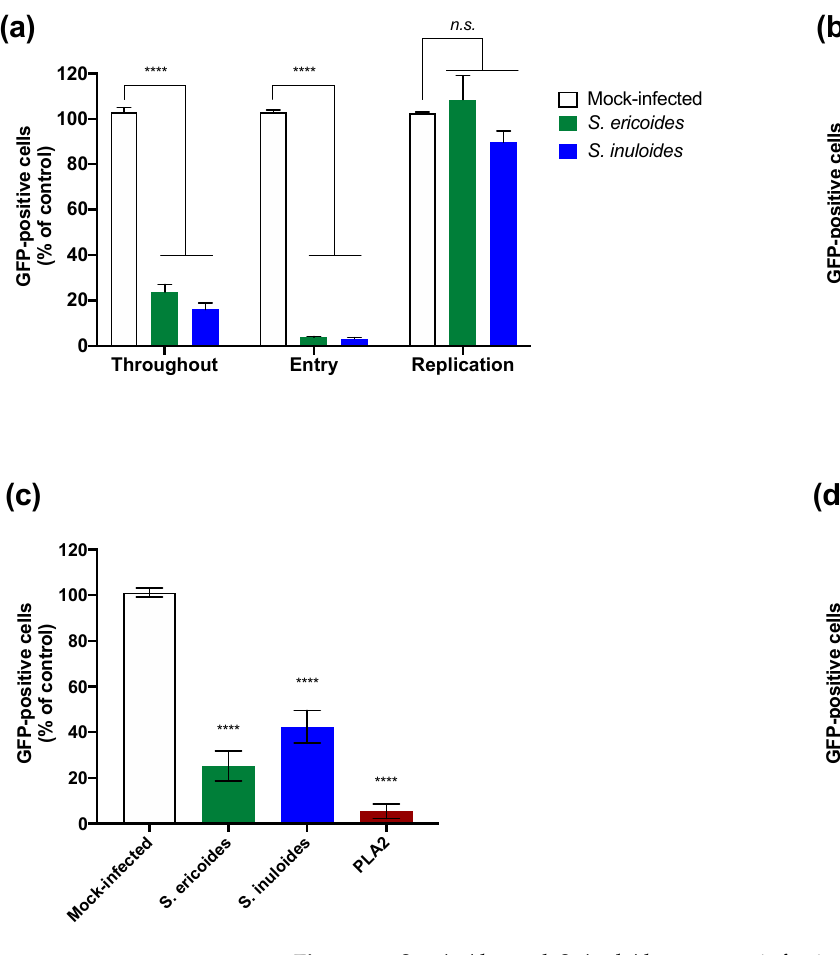
Figure 3. S. ericoides and S. inuloides prevent infection of A549 cells by acting differently on the early stages of ZIKV infectious cycle. ( a ) Flow cytometric analysis of GFP expression in ZIKV GFP - A549 infected cells during 24 h at different times of addition of Stenocline extracts (100 µ g.mL − 1 ). ( b ) A549 cells were infected with ZIKV GFP pre-incubated during 1 h at 37 ◦ C with 100 µ g.mL − 1 of Stenocline extracts. Phospholipase A2, PLA2 (10 µ M) was used as a positive control. Flow cytometric analysis of GFP fluorescence was performed 24 hpi. ( c ) A549 cells were infected with ZIKV GFP at an MOI of 1 for 1 h at 4 ◦ C in the presence of Stenocline extracts (100 µ g.mL − 1 ), and then the temperature was shifted to 37 ◦ C in absence of plant extracts. Phospholipase A2, PLA2 (10 µ M) was used as a positive control. Flow cytometric analysis of GFP fluorescence was performed at 24 hpi. ( d ) A549 cells were infected for 1 h with ZIKV GFP at 4 ◦ C, then the temperature was shifted to 37 ◦ C in presence of Stenocline extracts (100 µ g.mL − 1 ). Isoquercitrin, Q3G (100 µ M), was used as a positive control. Flow cytometric analysis of GFP fluorescence was performed at 24 hpi. Data represent the means ± SD from three independent experiments. A one-way ANOVA and Dunnett’s test were performed for statistical analysis (* p < 0.05; *** p < 0.001; **** p < 0.0001; n.s. = not significant). The Stenocline extracts’ inhibitory action on a later post-adsorption step of ZIKV infectious cycle was assessed, thereby evaluating their effect on virus internalization step. Thus, A549 cells were challenged with ZIKV GFP at 4 ◦ C for 1 h, without treatment with plant extracts, to allow virus binding, and temperature was then shifted to 37 ◦ C to initiate virus internalization in the presence of 100 µ g.mL − 1 of S. ericoides or S. inuloides extracts (Figure 3d). ZIKV-infected A549 cells were monitored for GFP expression at 24 h post- infection. Q3G, a flavonoid which is known to inhibit ZIKV entry [20], was used as